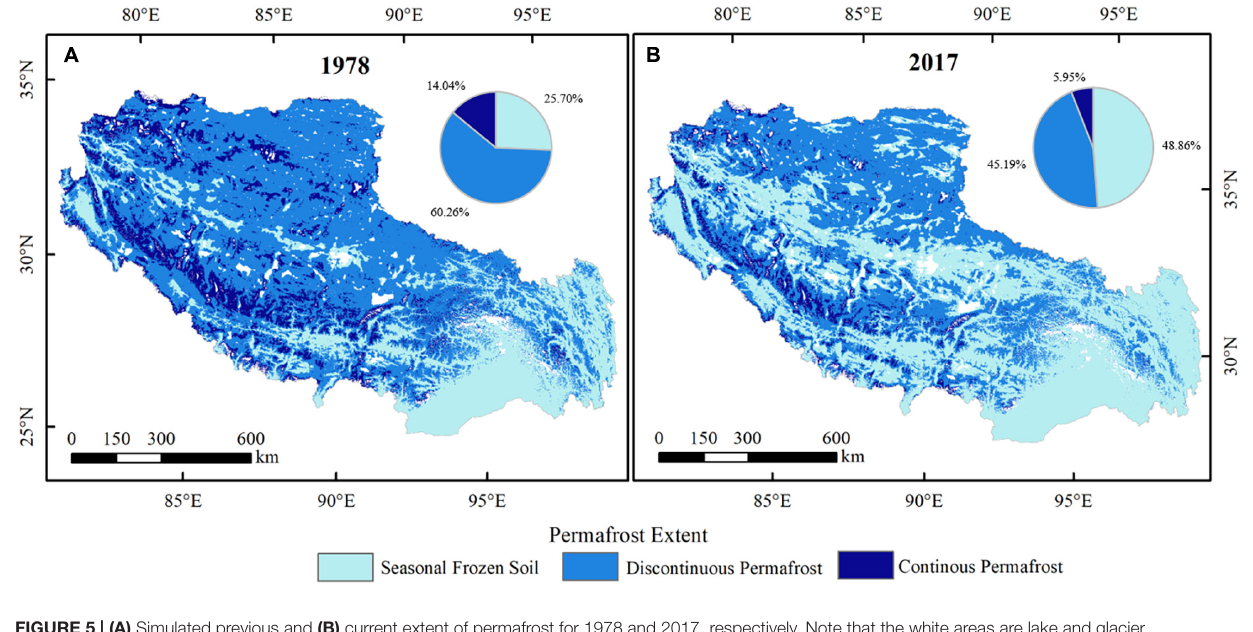
TABLE 2 | Permafrost transformation matrix over Tibet between 1978 and 2017 (Unit: km 2 ). 2017 Total Proportion Seasonally frozen ground Discontinuous permafrost Continuous permafrost 1978 Seasonally frozen ground 294732.94 (25.67%) / / 294732.94 Discontinuous permafrost 265899.84 (23.16%) Continuous